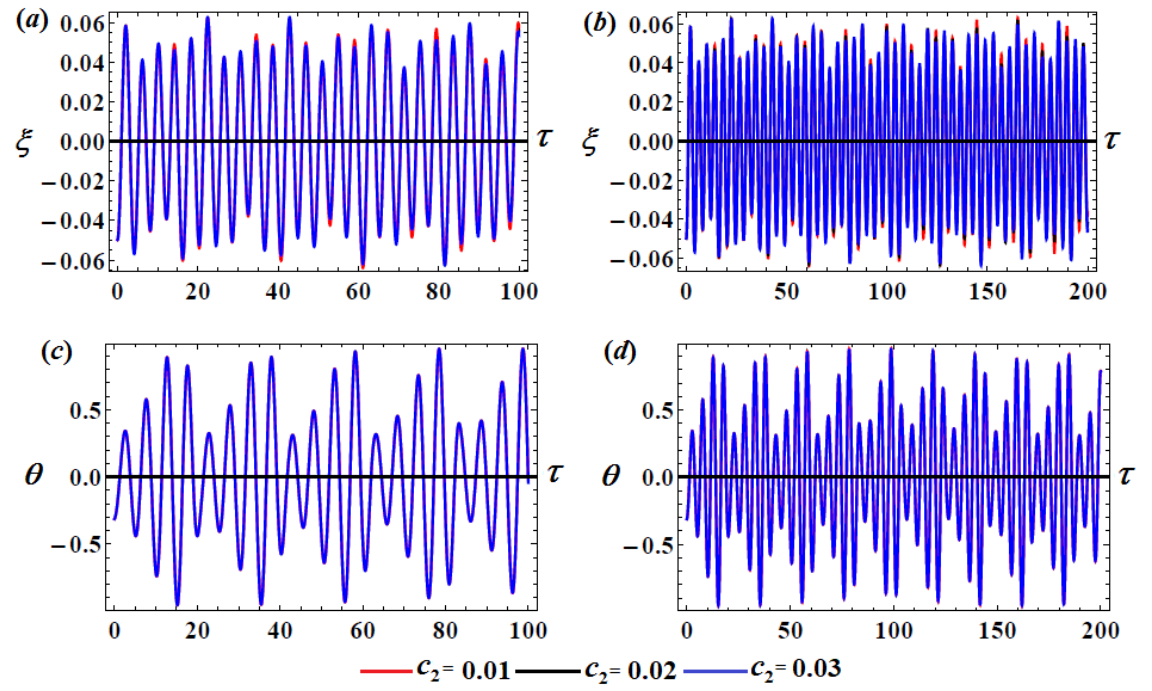
2 Figure 5. Impact of c 2 (= 0.01,0.02,0.03 ) m − 2 on the behavior of ξ and θ : ( a , c ) at t ∈ [ 0,100 ] s and ( b , d ) at t ∈ [ 0,200 ] s . (= 0.01,0.02,0.03) c m − on the behavior of  and  : ( a , c ) at [0,100] t s  and ( b , d ) at Figure 5. Impact of 2 [0,200] t s  .